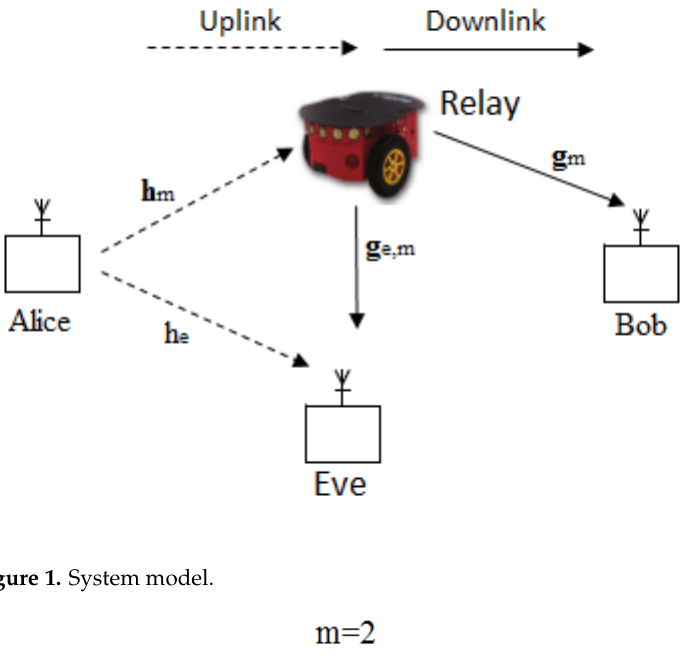
Figure 1. System model.